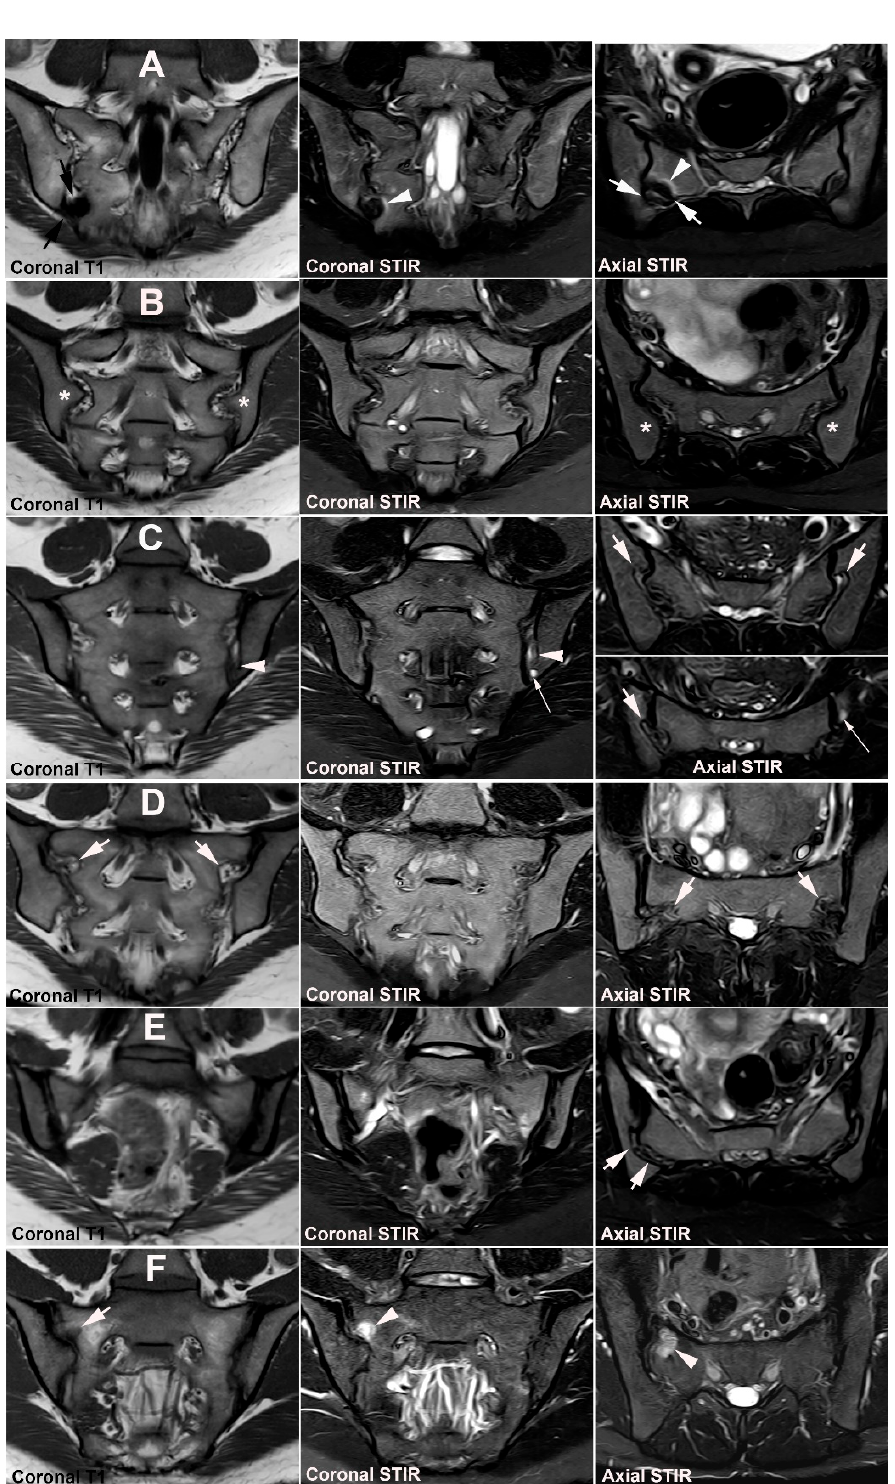
Figure 8. Anatomical SIJ variation. The figures illustrate the spectrum of SIJ variations, except unfused sacral nuclei illustrated separetely. Semi-coronal T1-weighted images to the left, semi- coronal STIR images in the middle, and semi-axial STIR images to the right. ( A ) : Accessory (ACC) SIJ is an additional small joint in the ligamentous joint compartment with opposing articular joint facets. It can be bilateral or unilateral and is most frequent at the level of S2 but can also occur at S1 and S3 [25,46]. ACC SIJ is best visualized on semi-axial slices but can be confirmed in the semi- coronal plane by the lack of interposed fat and ligaments between the joint facets (black arrows). In this patient presenting with pain, there is concomitant subchondral sclerosis at the ACC joint (white arrows) surrounded by a brim of osseous edema (arrowheads). ( B ) : Iliosacral complex consists of an osseous protrusion of the iliac bone in the ligamentous joint compartment (asterisks) with a corresponding groove in the opposing sacral bone visualized in both the semi-coronal and semi- axial plane. ( C ) : Bipartite iliac bony plate is a cleft-like appearance in the posterior/inferior part of the iliac bone best visualized in the semi-axial plane (arrows). It is formed by a deep insertion of a posterior iliosacral ligament [30] which is often surrounded by vessels causing edematous changes as seen on the semi-coronal and inferior semi-axial STIR images (long thin arrow). On semi-coronal